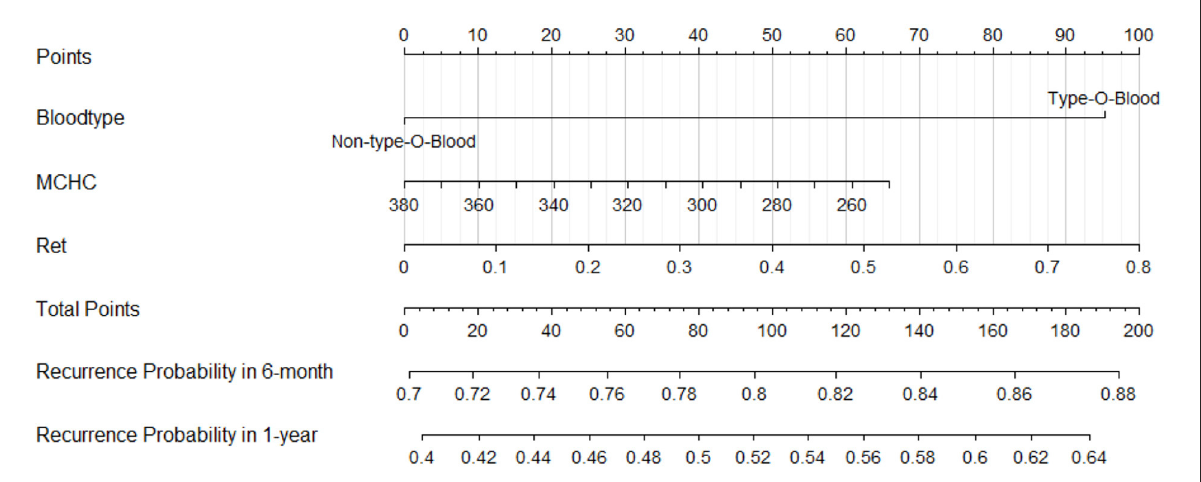
FIGURE4 A nomogram to calculate and predict the recurrence probability in 6 months and 1 year after the initial